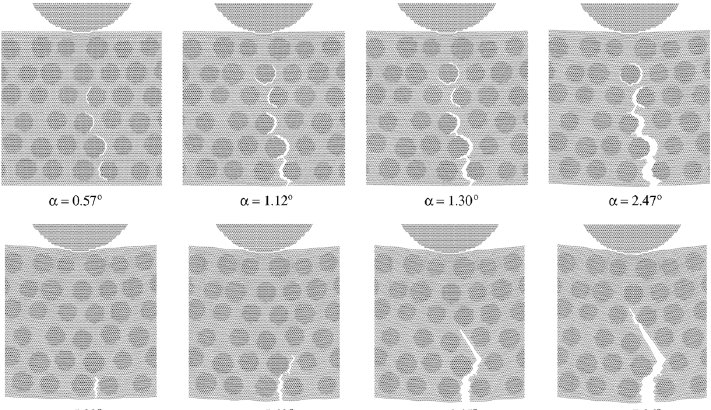
Figure 15: Dynamics of fracture in metal-ceramic composite specimens characterized by different values of the strength of interface